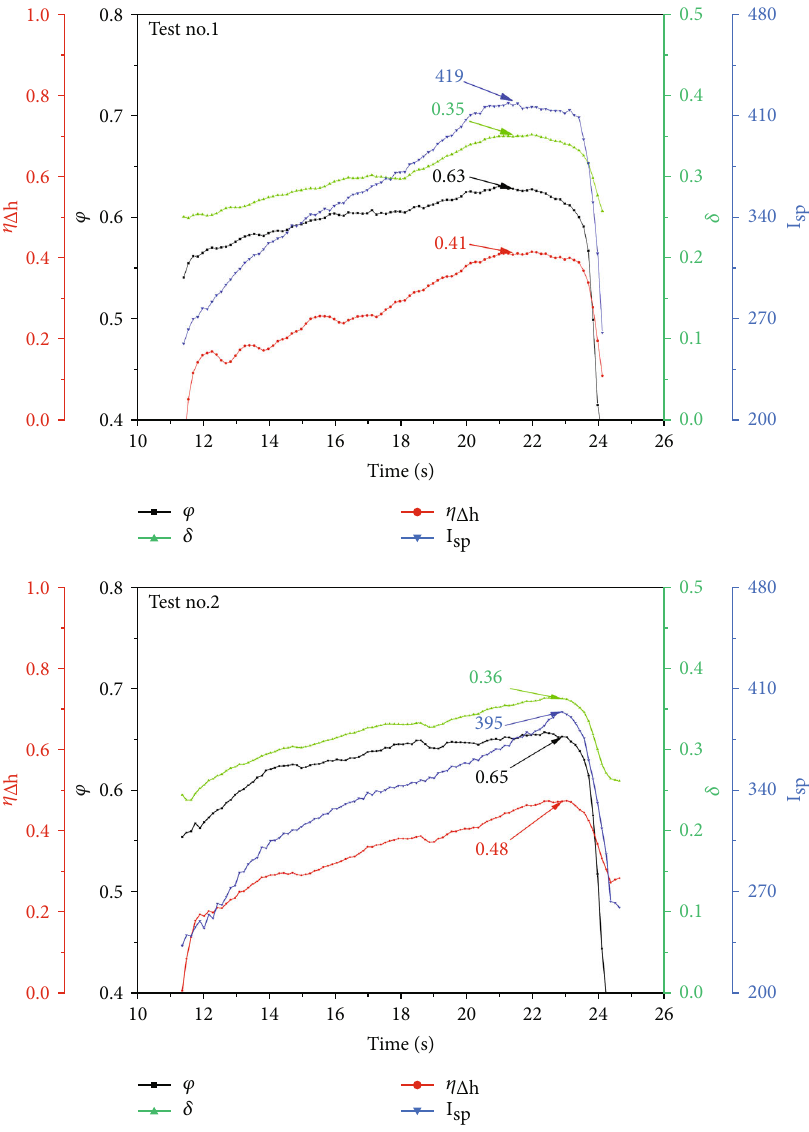
Figure 16: Evolution of SSRJ combustor performance during the two